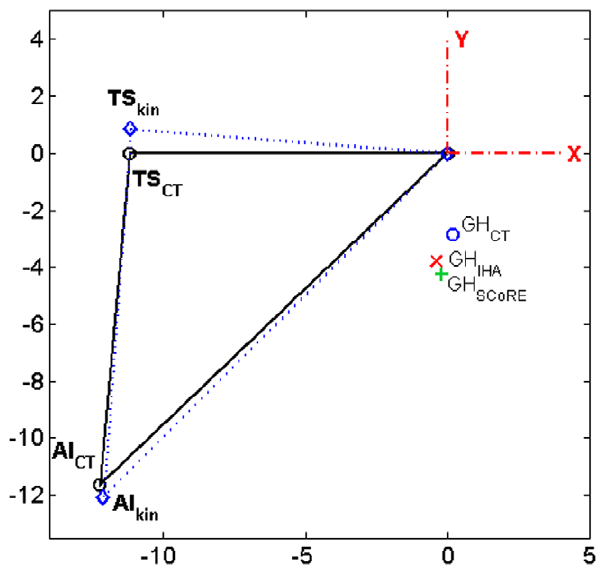
Figure 3. The kinematic and geometric GH-JRC as well as the scapular anatomical landmarks in the xy -plane. The mean values of the four subjects in Table 3 are used. The AA-point was used to align the kinematic (GH IHA and GH SCoRE ) and CT-based (GH CT ) coordinate systems. The axes are in cm.